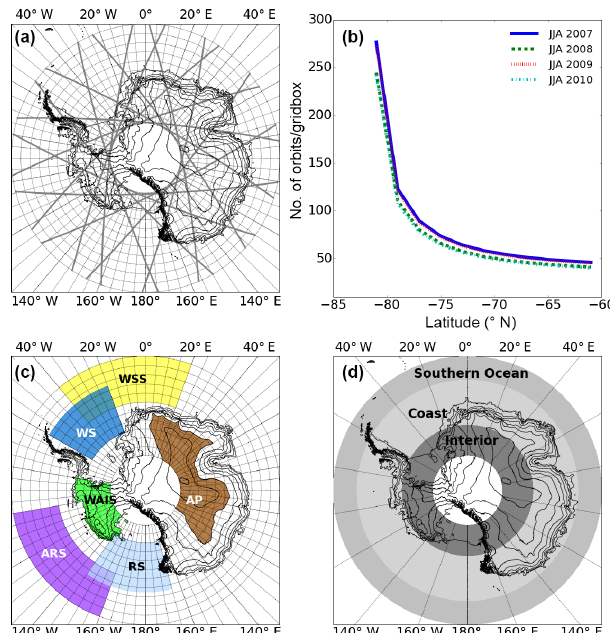
Figure 4. (a) The Cloudsat tracks across the Antarctic on 1 Jan- uary 2007, and the grid (grid boxes of 2 ◦ in latitude and 5 ◦ in lon- gitude) used to derive the geographical distribution of cloud occur- rences and extending between 60 and 82 ◦ S (b) The zonally aver- aged number of satellite overpasses per grid box as a function of latitude, for the whole winter season each year. (c) Areas of inter- est used in the study and introduced in Sect. 4.3 to investigate the monthly evolution of cloud occurrences. They are called WSS (in the Weddell Sea sector), ARS (in the Amundsen–Ross sector), WS (in the Weddell Sea), RS (in the Ross Sea), the WAIS (on the West Antarctic Ice Sheet) and AP (on the Antarctic Plateau). Names are recalled in Table 1. (d) The three latitudinal bands used for the av- erage vertical transects presented in Sect.